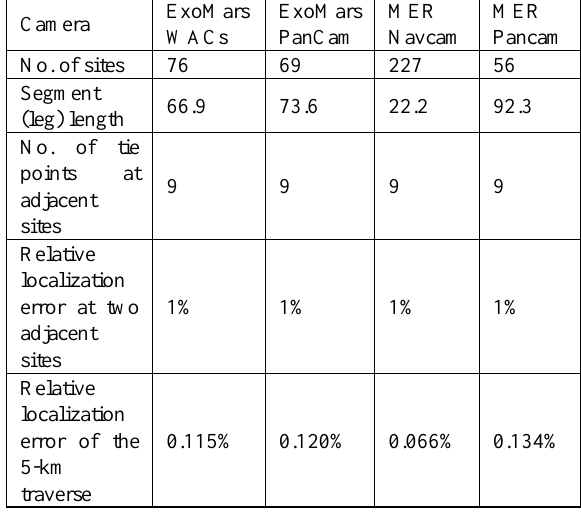
Table 2. Multiple-site rover traverse design and error analysis for a 5-km